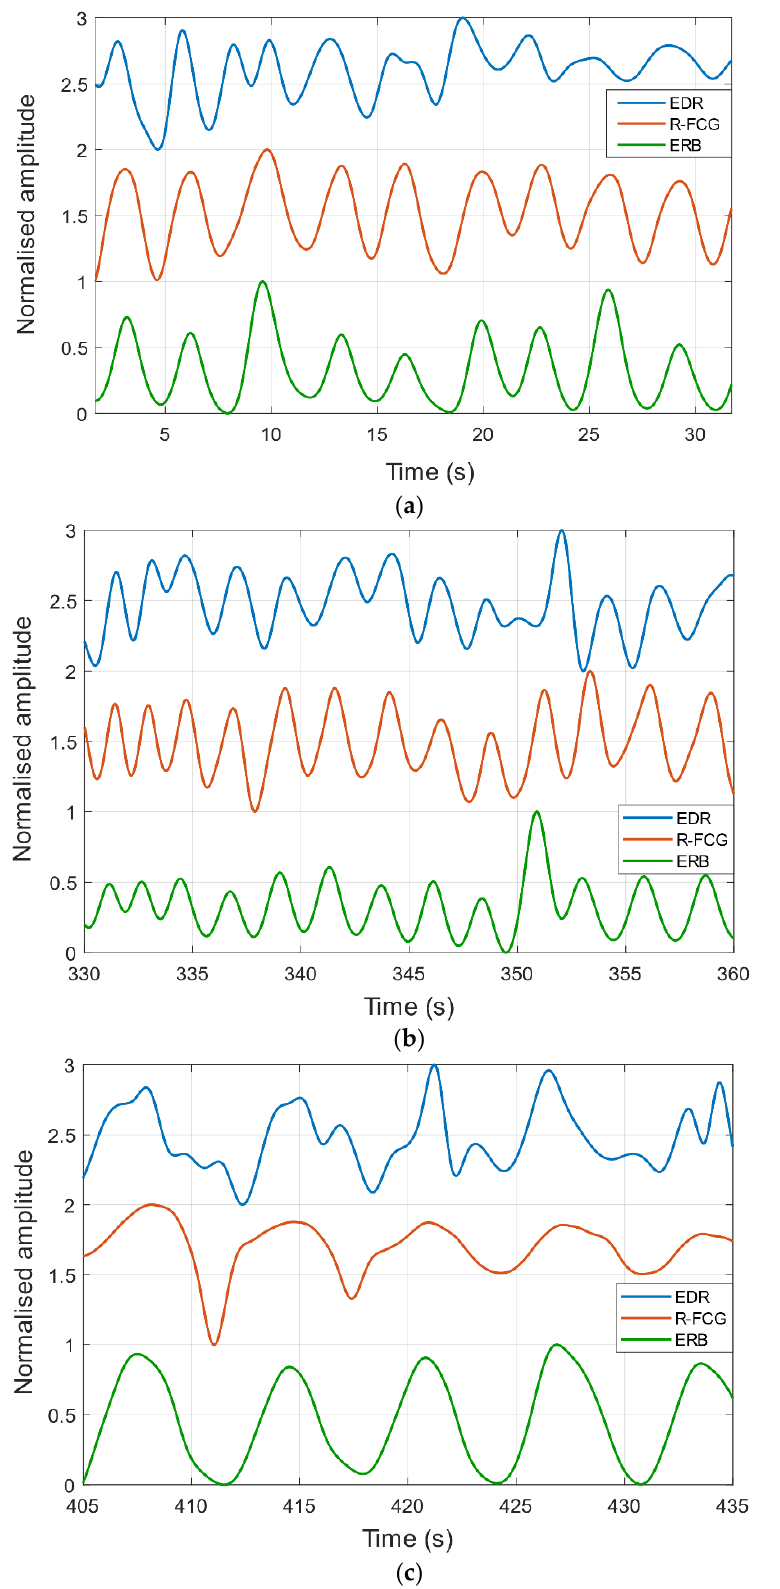
Figure 5. Examples of ERB, R-FCG and EDR signals extracted from data acquired on subject #3: ( a ) quiet breathing; ( b ) forced breathing at higher rate; ( c ) forced breathing at lower rate.